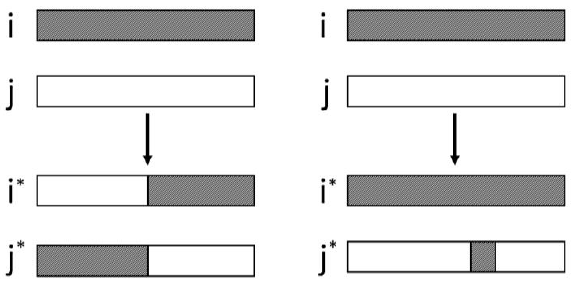
Figure 1. Crossover operator in Simple Genetic Algorithm (SGA) ( left ) and Simple Microbial-Genetic Algorithm (SMGA) ( right ) evolutionary algorithms. In both algorithms i , j are the parental chromosomes. In SGA i * , j * are the recombinant chromosomes replacing the parental ones. In SMGA, j * is the recombinant chromosome.